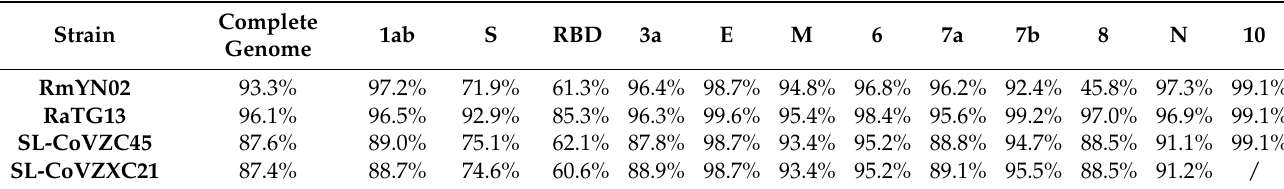
Table 1. Nucleotide sequence identity across the whole genome, individual ORFs coding for structural and accessory proteins, and receptor binding domain (RBD) (%) for SARS-CoV-2 compared with representative related beta-CoVs genomes. Adapted from [14].